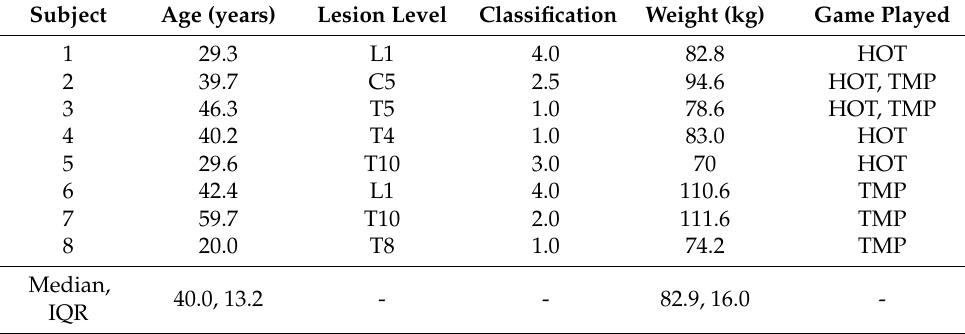
Table 1. Participants’